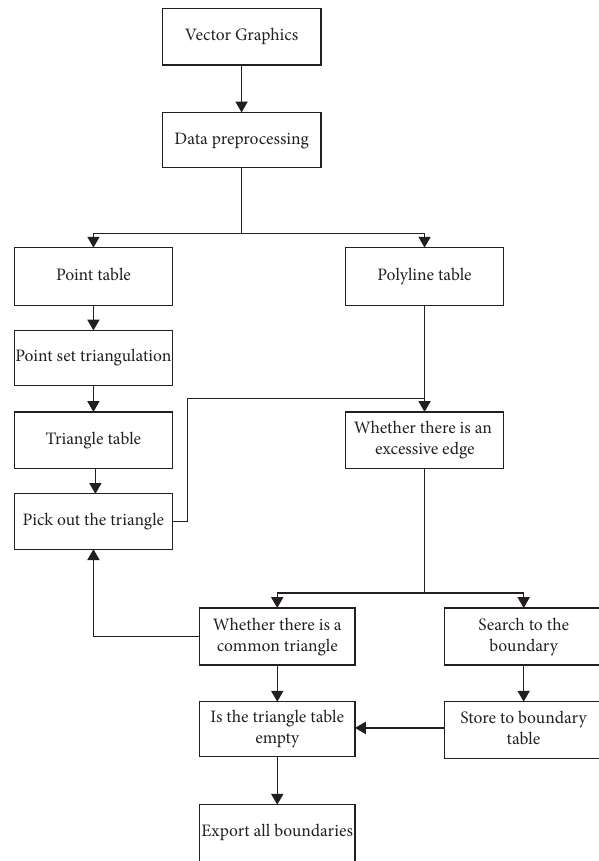
Figure 3: extraction of vector graphics boundary by triangulation